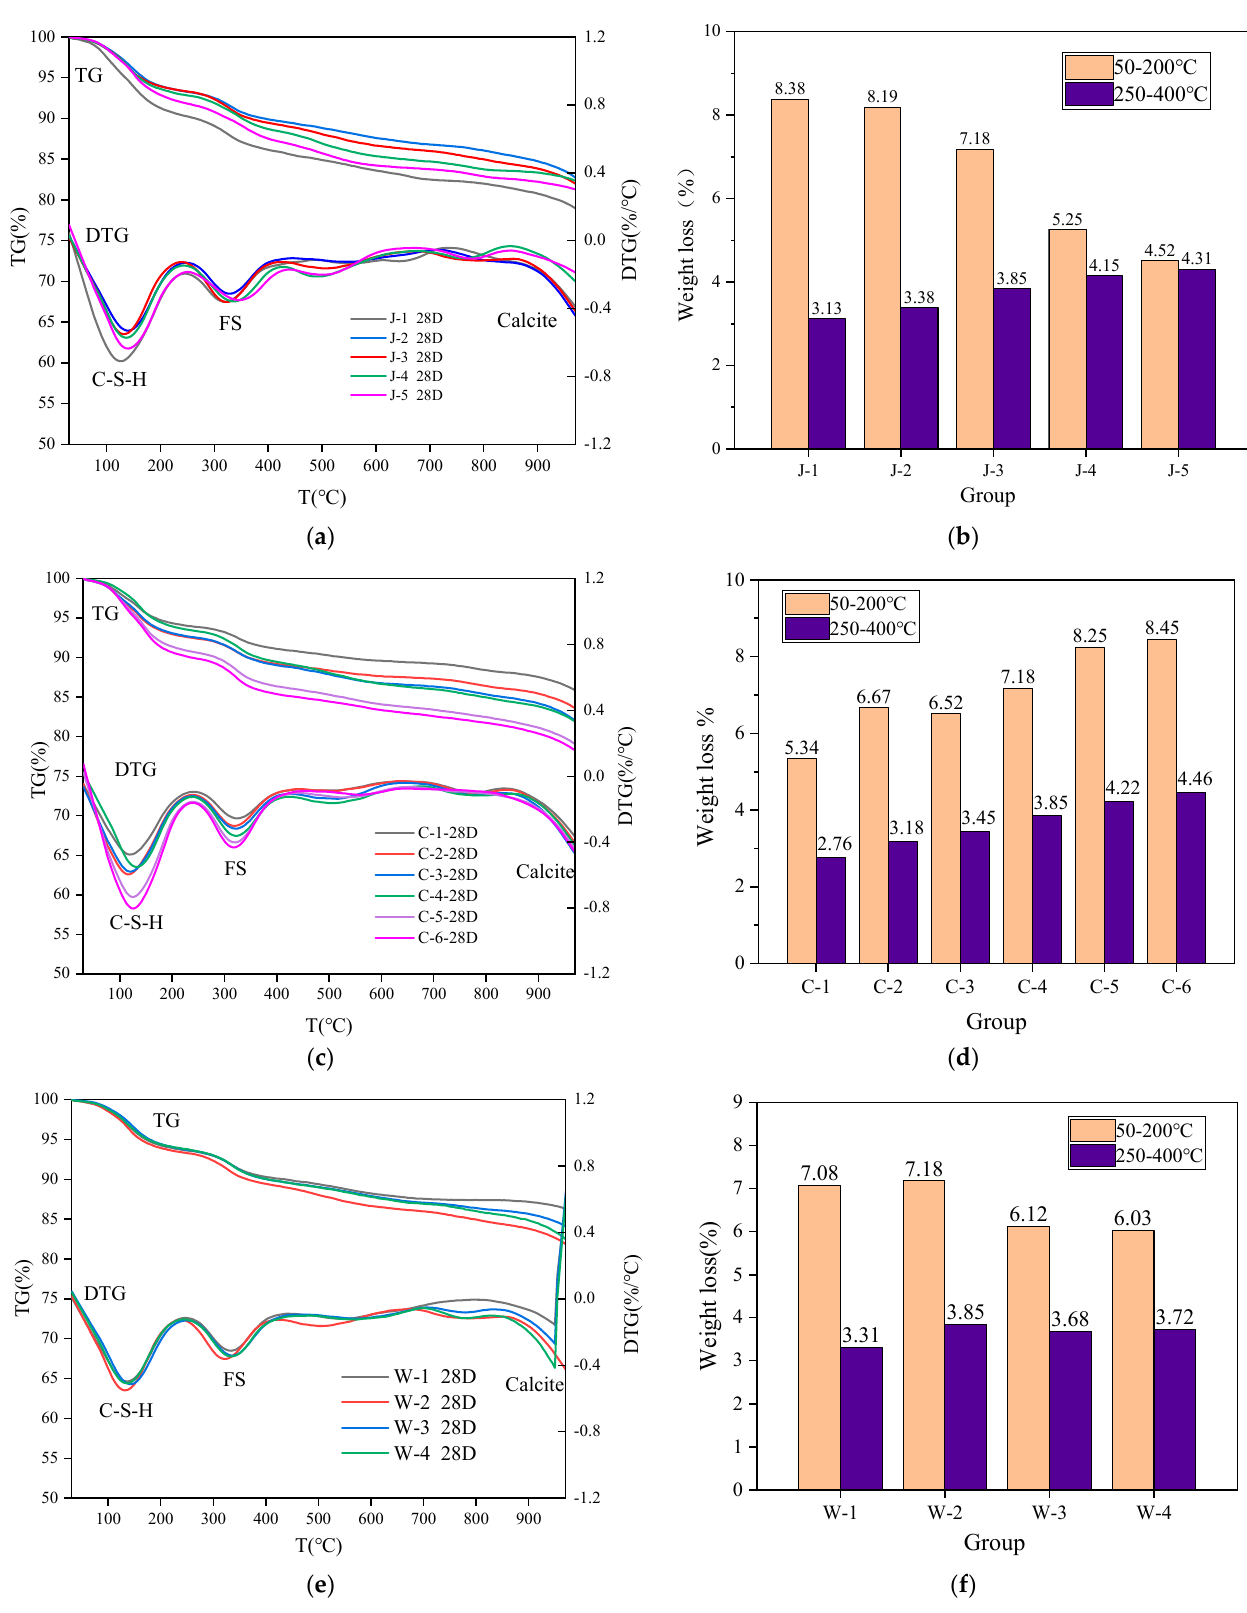
Figure 6. TG-DTG curves ( a , c , e ) and weight loss ( b , d , f ) of all 28 d specimens at di ff erent groups.